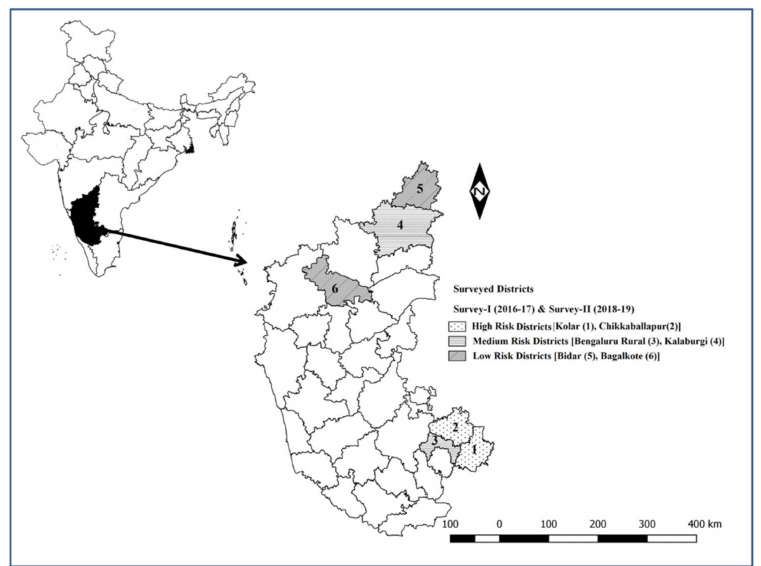
Figure 1. Districts with a high risk (Kolar (1), Chikkaballapur (2)), medium risk (Bangalore rural (3), Kalaburgi (4)), and low risk (Bidar (5), Bagalkote (6)) surveyed in Karnataka during survey I (2016–2017) and survey II